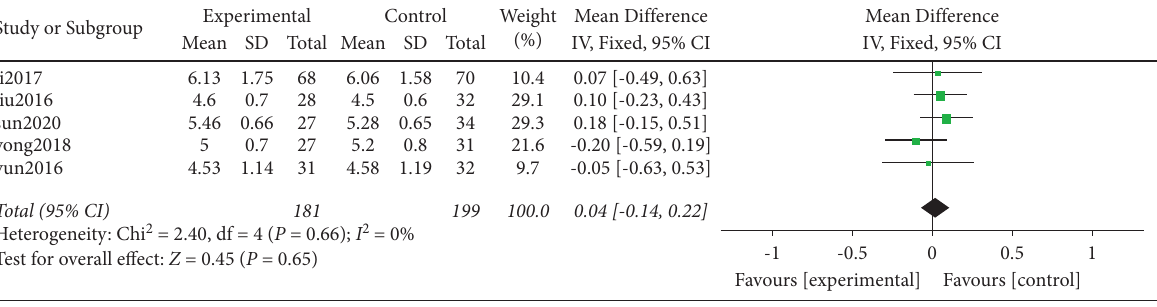
Figure 6: Preoperative DHI.